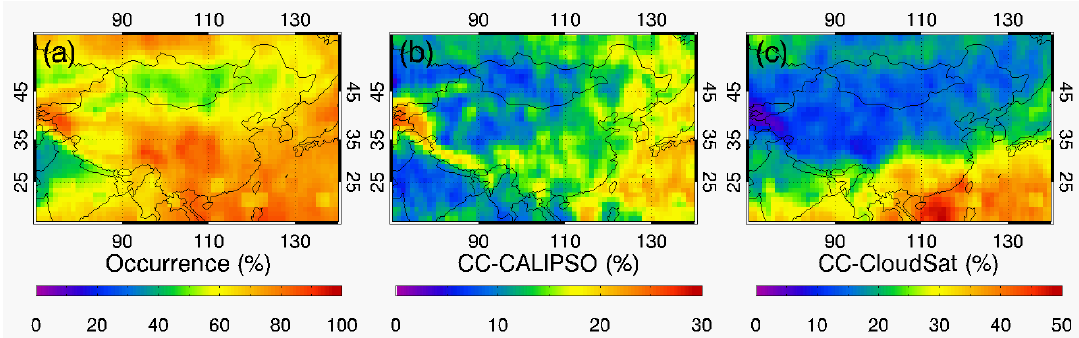
Figure 2. ( a ) Cloud occurrence frequencies from four-year (2007–2010) CloudSat 2B-CLDCLASS-LIDAR product; ( b ) differences of cloud occurrence frequencies between the CloudSat 2B-CLDCLASS-LIDAR product and the CALIOP Level 2 5-km cloud layer product; ( c ) differences between the CloudSat 2B-CLDCLASS-LIDAR product and the 2B-GEOPROF product. CC in the figure represents combined CPR and CALIOP measurements employed in the CloudSat 2B-CLDCLASS-LIDAR product.